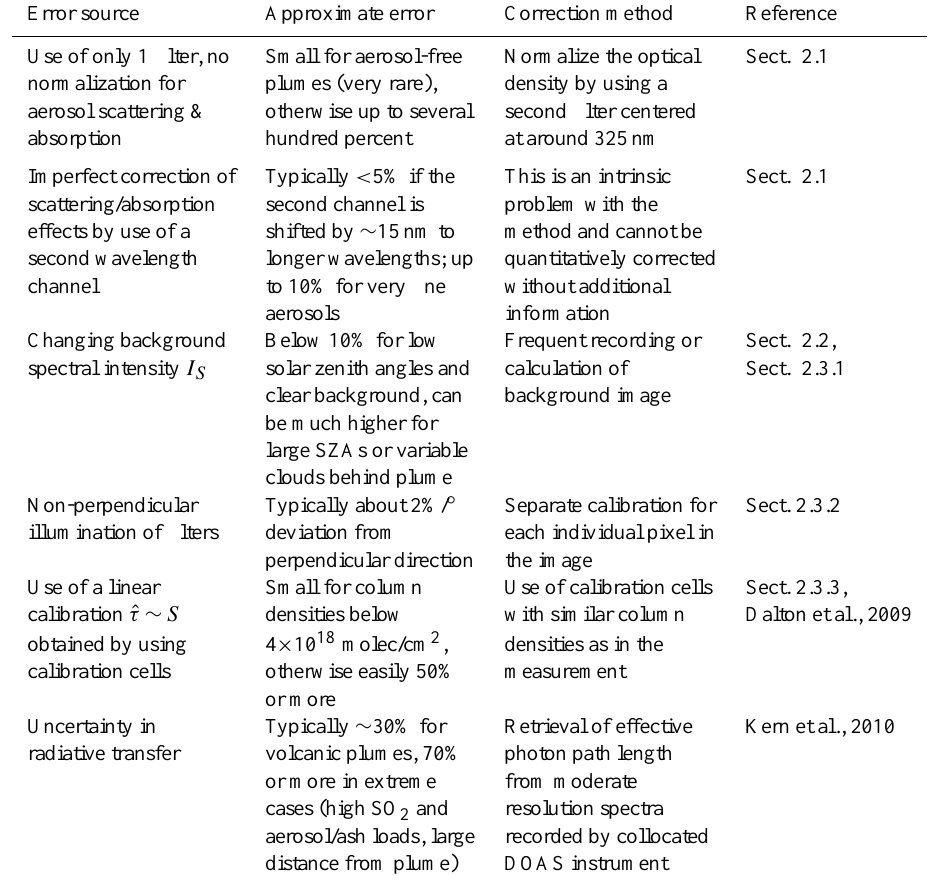
Table 1. Overview of the different error sources inherent in SO 2 camera measurements and the approximate magnitude of the associated errors. Also given are methods to correct for the errors if